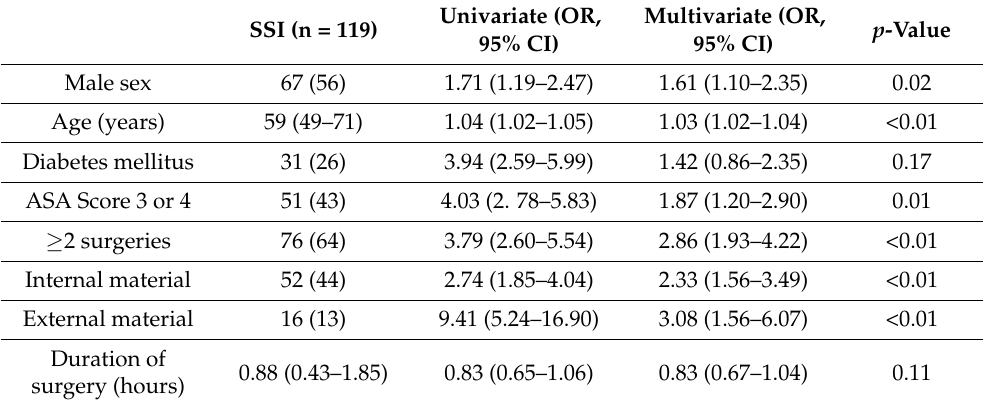
Table 3. Risk factors for surgical site infections in the entire cohort.